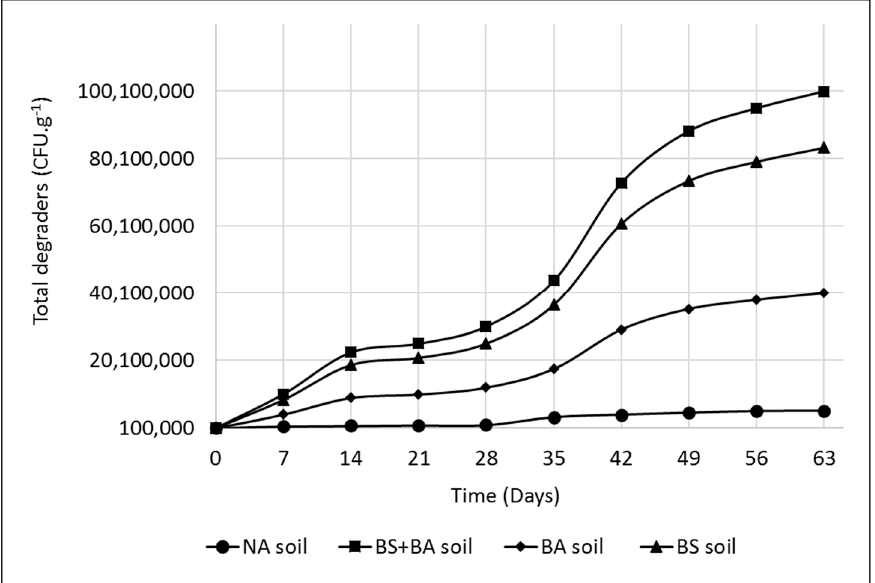
Figure 4. Total degrader bacteria numbers in soil samples over 63 days.